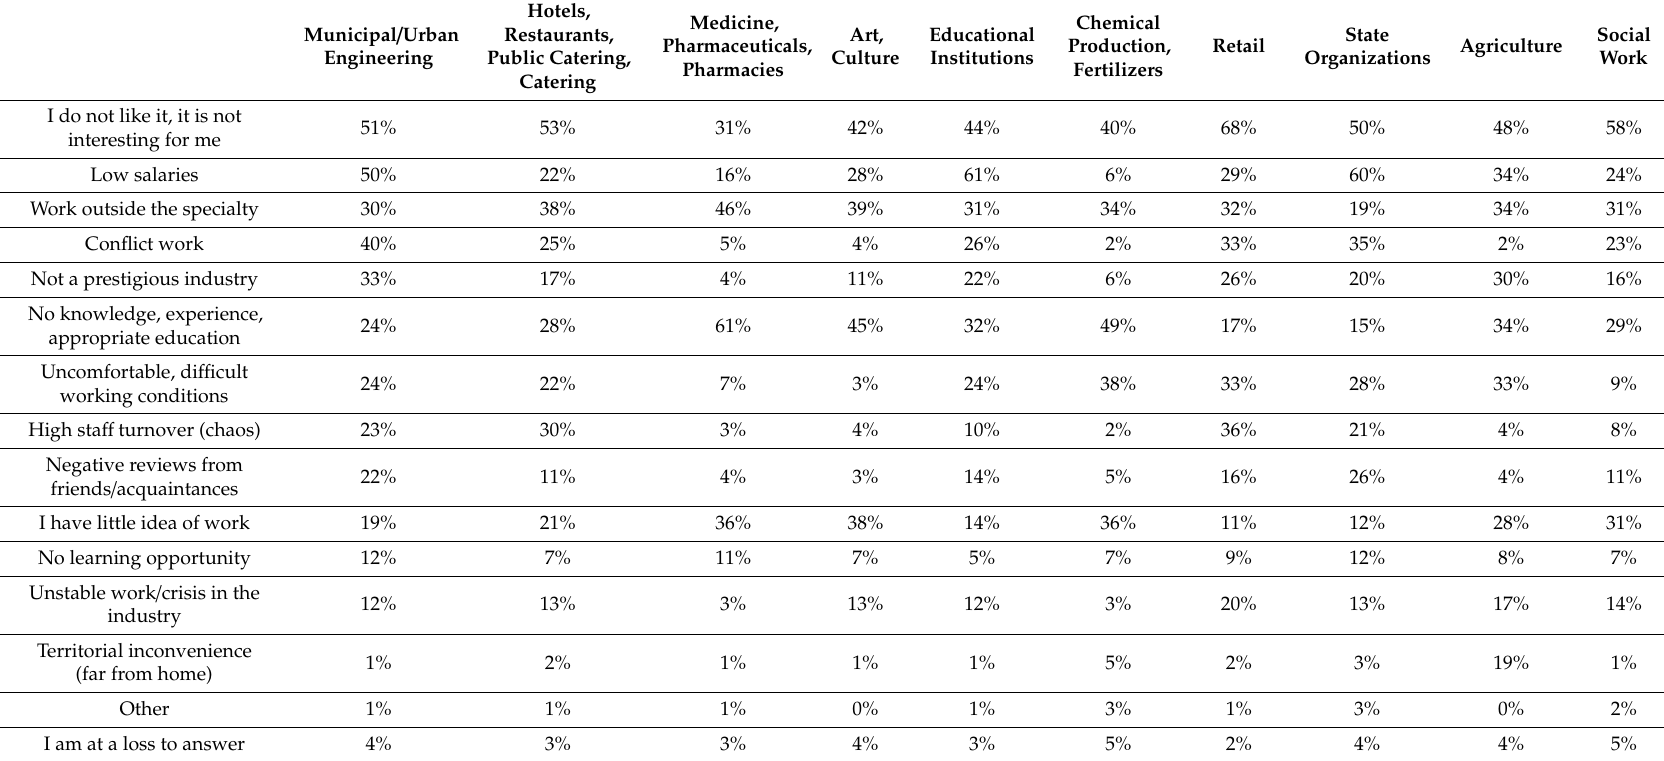
Table 2. Reasons why industries are unattractive for applicants (Almanac HeadHunter